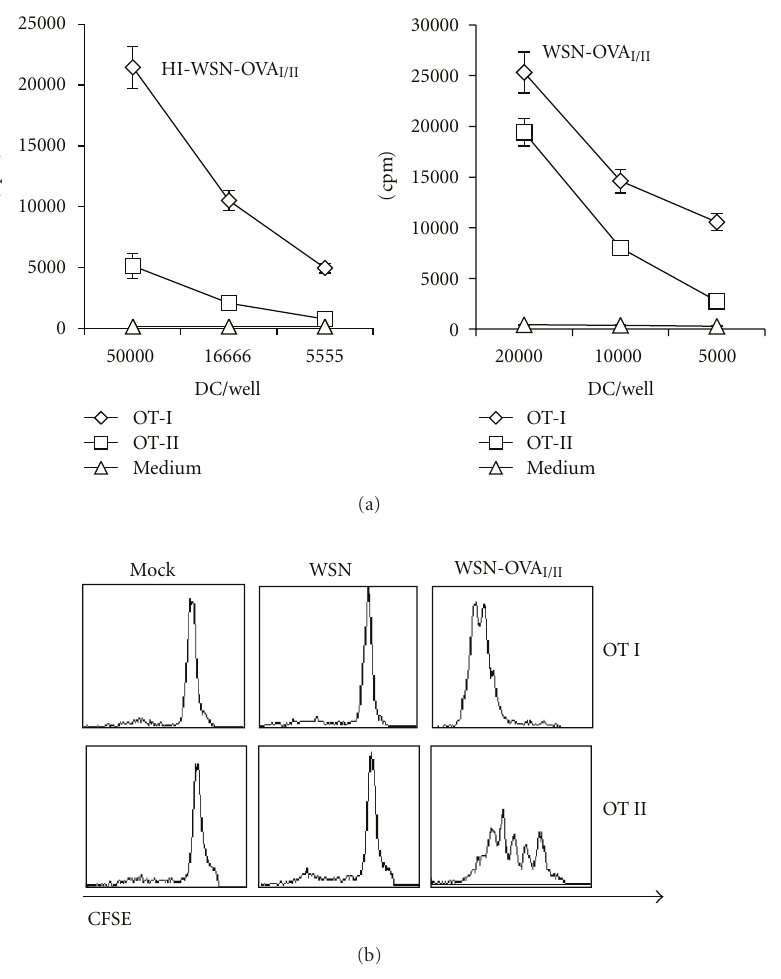
Figure 2: Presentation of WSN-OVA I / II virus by dendritic cells (DCs) in vitro to OVA-specific CD8+ and CD4+ T cells. (a) Splenic DCs were incubated with either live or heat-inactivated (HI) WSN-OVA I / II virus and then washed and titrated in microtiter plates. OT-I cells and OT-II cells were added to the cultures (10 5 /well), and T cell proliferation was estimated by use of [ 3 H]thymidine incorporation two days later. The data shown are the means ( ± SEM) from triplicate cultures. (b) CFSE-labelled na¨ıve OT-I and OT-II cells were coincubated with live virus-pulsed or control DCs. Three days later, proliferation of CD8+ and CD4+ T cells was determined by using flow cytometry. The results shown are representative of three